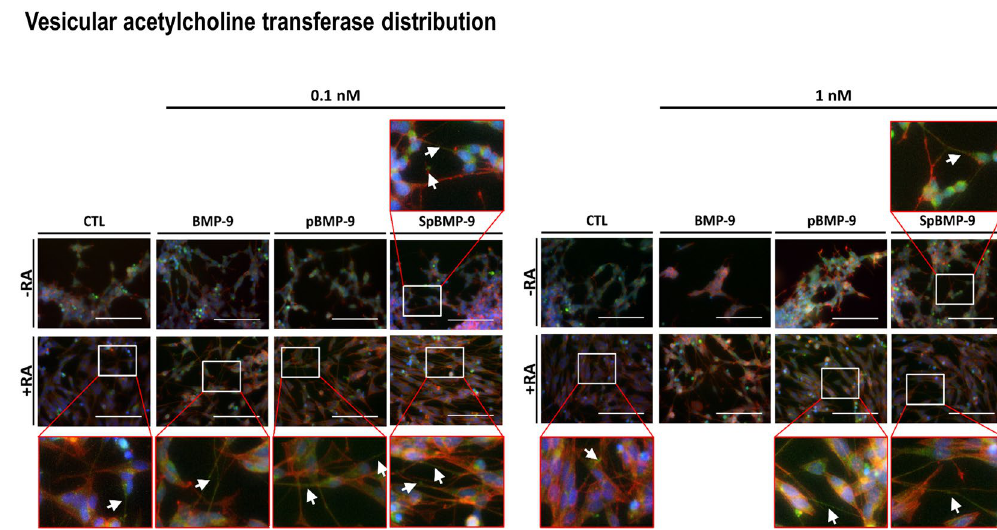
Figure 6. Effect of pBMP-9 and SpBMP-9 on the expression and the distribution of VAchT. Merged pictures showing immunostaining for VAchT (FITC, green), actin cytoskeleton (rhodamine-phalloidin, red) and nuclei labelling (Hoechst, blue) of SH-SY5Y cells stimulated for 5d with 0, 0.1 or 1 nM BMP-9, pBMP-9 and SpBMP-9 + / − 10 μ M RA. White squares show magnified zones, white arrows indicate VAchT vesicles in cell neurites (Bar = 100 μ m). Pictures are representative of at least 2 independent